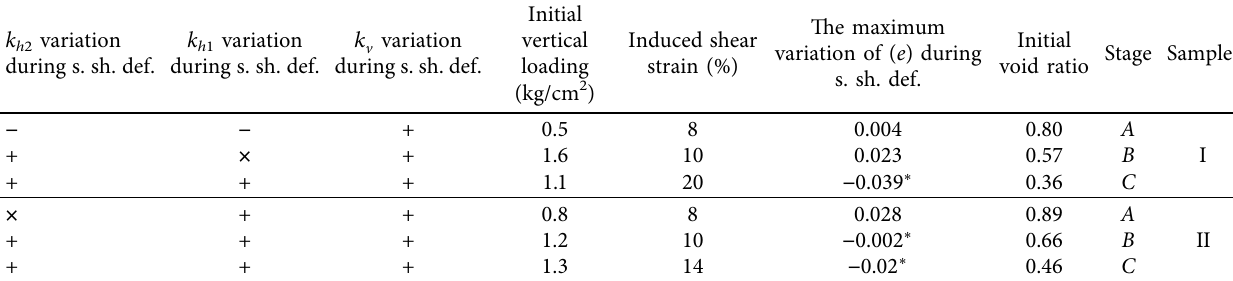
Figure 9: Variation graphs of k Table 2: Specifications of samples and their permeability change behaviour during simple shear deformation tests. k h 1 variation k h 2 variation during s. sh. def. during s. sh. def.